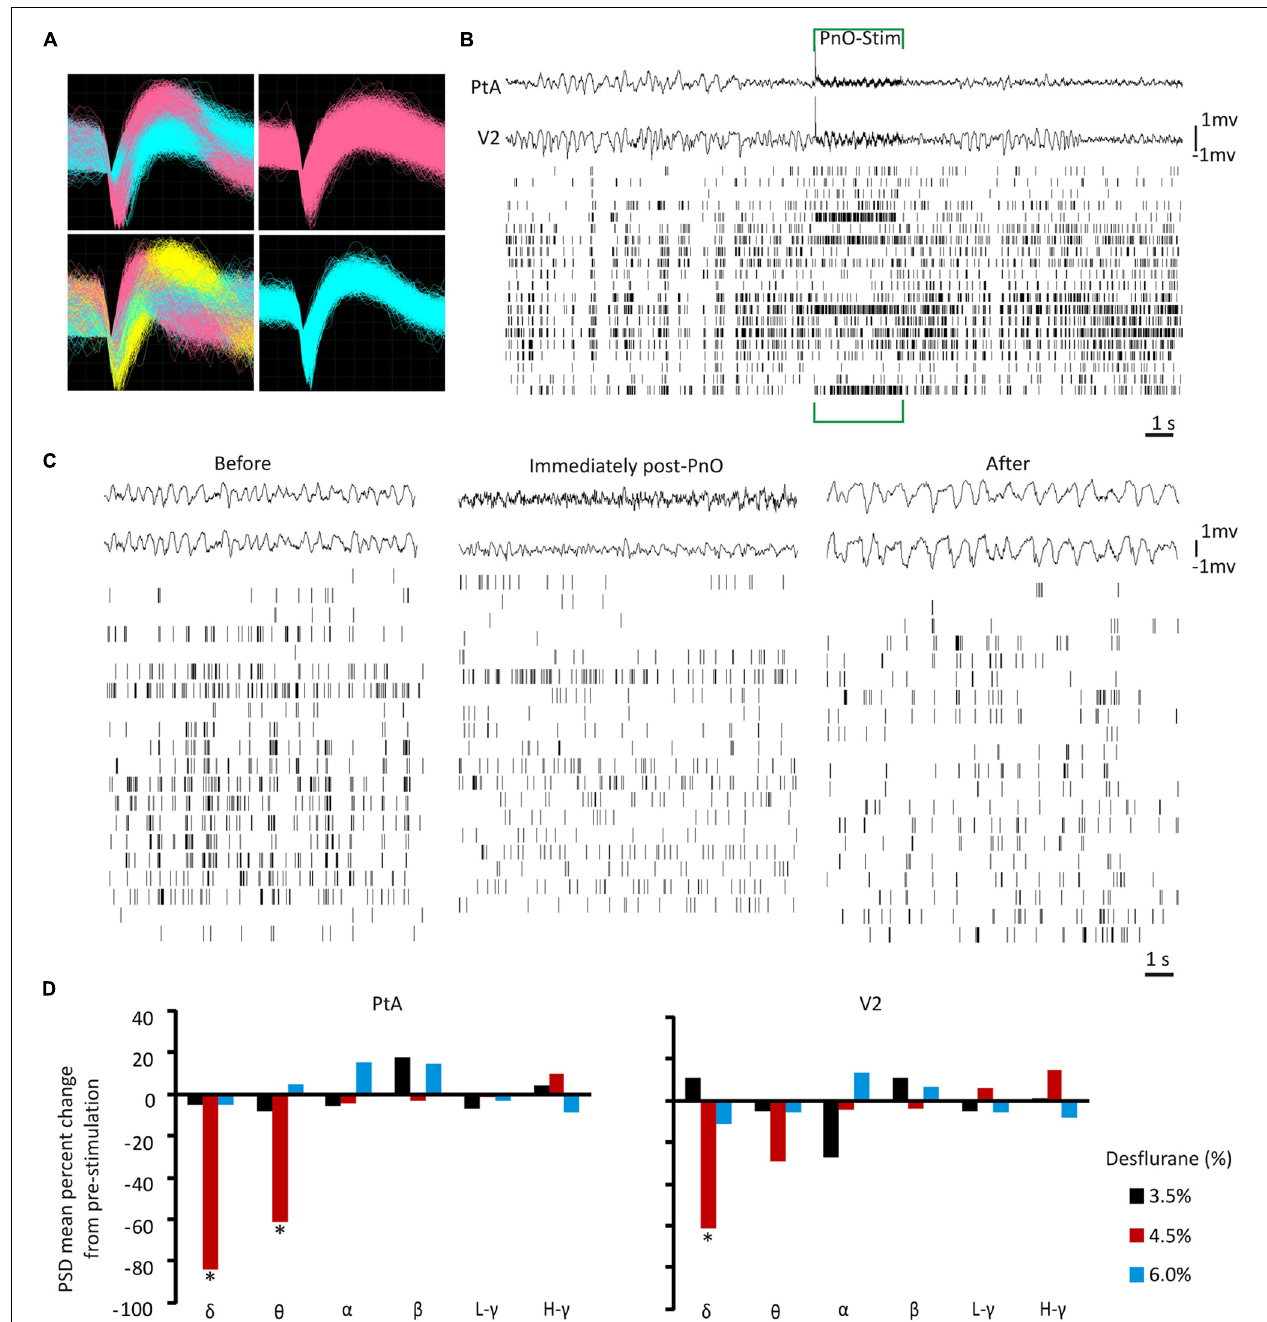
mostly high-amplitude activity, but became more desynchronized after PnO stimulation.The two LFP traces were chosen from each region (PtA = top waveform,V2 = bottom waveform).The spike raster plots show all active units from this rat. (D) LFP band power percent change from pre-stimulation. PnO stimulation elicited cortical arousal, as determined by the induced significant reductions in delta and theta band powers in the PtA at 4.5% desflurane. Delta band power was also reduced inV2 after PnO stimulation at 4.5% desflurane. No change in band powers was observed at 6.0% desflurane. * p < 0.05 for post- vs. pre-PnO stimulation. δ = 1–4 Hz, θ = 5–7 Hz, α = 8–12 Hz, β = 13–30 Hz, low-gamma L − γ = 30–50 Hz, and high-gamma H − γ = 70–140 Hz. PSD = power spectral